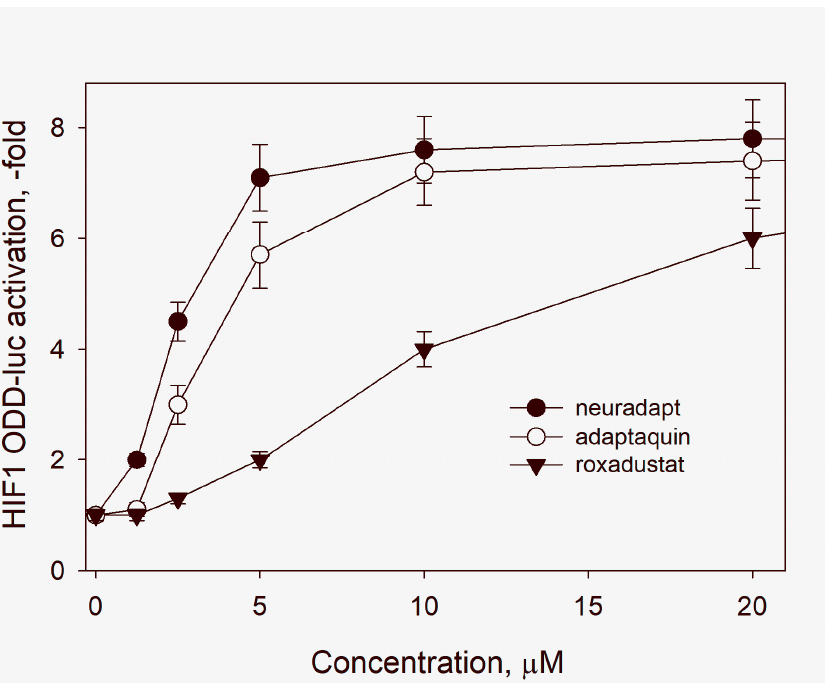
Figure 3. Cell-based reporter activation upon 3 h incubation with varied concentrations of HIF PHD inhibitors. Luminescence normalized to that in the absence of added inhibitors. Results presented as mean ± SD of triplicate measurement.